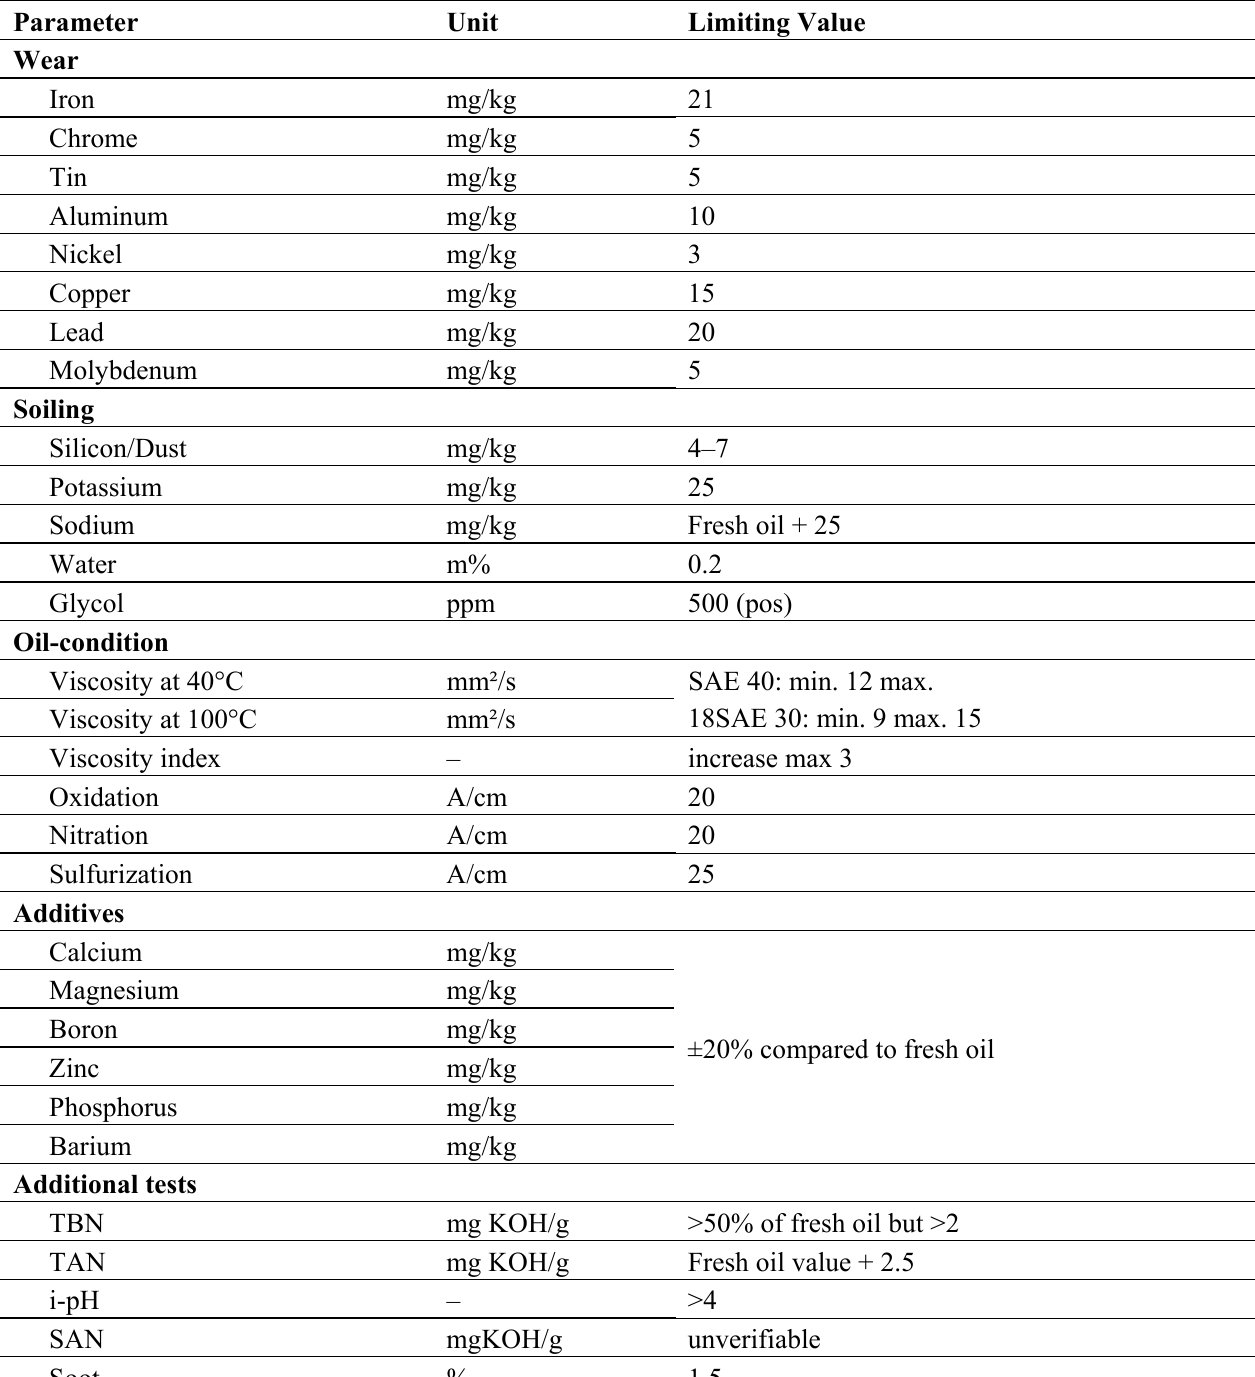
Table 1. Limiting values for oil in stationary Gas Otto engines